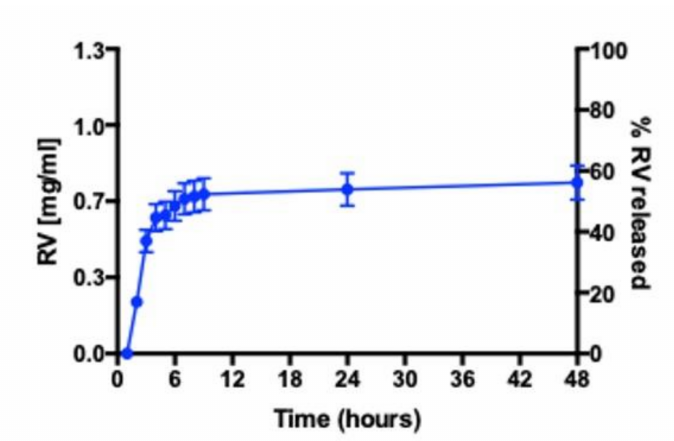
Figure 4. RV-loaded NEs: stability over time at two different temperatures—room temperature (RT) and 4 ◦ C.